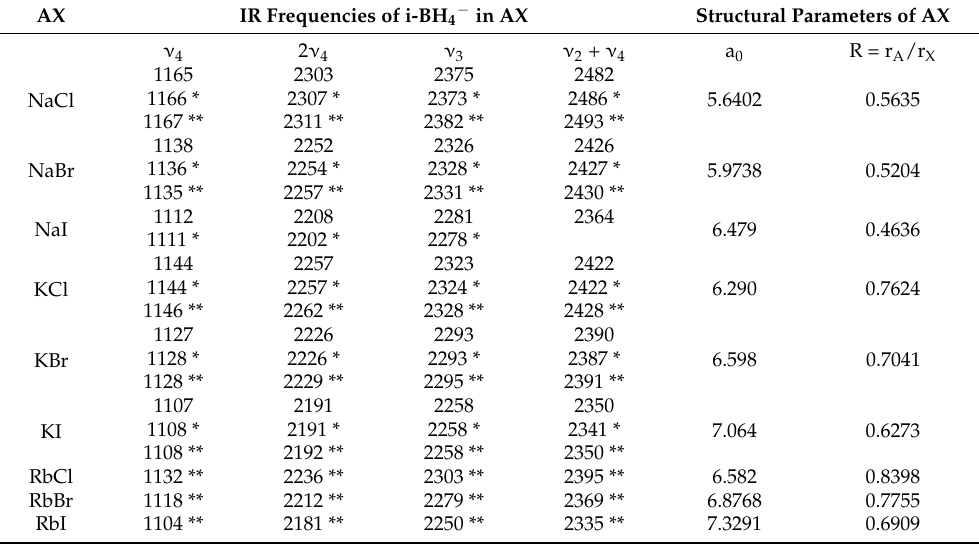
Table 3. IR frequencies of i-BH 4 − in different AX. Structural parameters of AX are also given. AX IR Frequencies of i-BH 4 − in